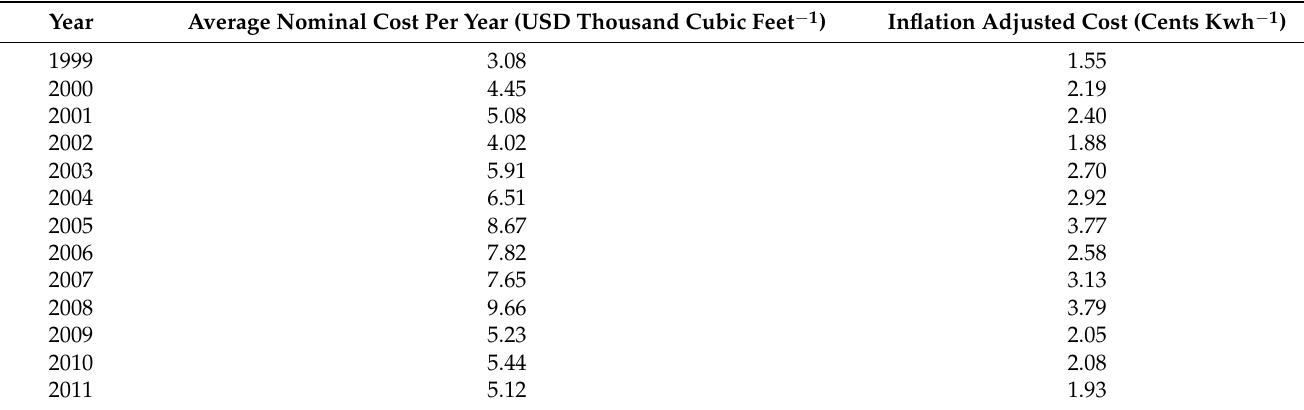
Table A11. Annual United States national industrial natural gas costs